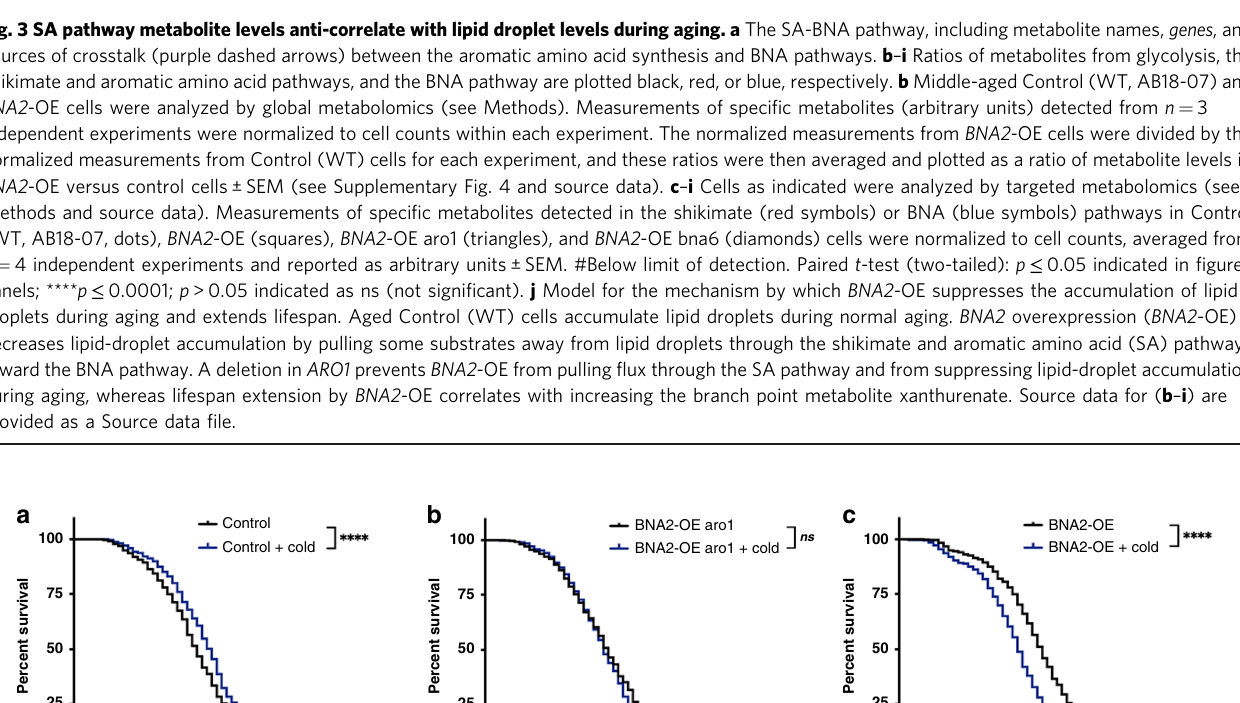
Fig. 4 Increased survival to cold exposure correlates with LD accumulation during aging. a – c Cells as indicated were aged in 30 °C media until median age 16 (middle-age), and then exposed to 4 °C (blue lines) or 30 °C (black lines) media at regular intervals until death (see Methods), and lifespan was analyzed as in Fig. 1f (see Methods). Log-rank test: p > 0.05, not signi fi cant; **** p ≤ 0.0001. a Control (WT, AB18-07, 550 cells at 30 °C, and 525 cells at 4 °C), b BNA2 -OE aro1 Δ (525 cells at 30 and 4 o C), and c BNA2 -OE (550 cells at 30 and 4 °C) were analyzed over n = 4 independent experiments. Average median and maximal lifespans at 30 °C (±SEM): Control 25.8 ± 1.3, 41 ± 1.9; BNA2 -OE aro1 Δ 25.1 ± 2.2, 44.3 ± 4.2; BNA2 -OE 29.5 ± 1.7, 48.8 ± 2.5. Average median and maximal lifespans at 4 °C ( + SEM): Control 27.5 ± 1.3, 43.3 ± 2.5; BNA2 -OE aro1 Δ 25 ± 1.8, 45 ± 4.6; and BNA2 -OE 24.8 ± 1.3, 40 ± 3.7. Source data for ( a – c ) are provided as a Source data fi metabolomics data RAW fi les were converted to mzXML fi les using msconvert resuspended in water for analysis on a C18 column in negative ion mode, and from the open source software package ProteoWizard, version 3.0.8789 (http:// diluted 1:4 into acetonitrile for analysis on a HILIC column in positive ion mode. proteowizard.sourceforge.net/); identity and peak integration were manually All samples were analyzed using two separate LC-MS methods on Vanquish veri fi ed and quanti fi ed using the open source software program Maven, version UPLCs coupled to a Q-Exactive Plus mass spectrometers running Thermo Xcalibur 4.0 (version 4.0.27.10) with Thermo Foundation 3.1 SP1 (version 3.1.83.0) (ThermoFisher Scienti fi c, Waltham, MA). Metabolites analyzed in positive ionization mode were separated using a SeQuant ® ZIC ® -pHILIC column, 5 μ m particle size, 200Å, 150 ×2.1 mm. Mobile phase A was 20mM ammonium carbonate in water (pH 9.2); mobile phase B was (Fig. 3c – i, Source data fi le). Samples were reconstituted in 50:50 (v/v) mixture of acetonitrile. The fl ow rate was 150 μ L/min and the gradient was t = − 6, 80% B; t = 100% methanol and 0.4% (v/v) acetic acid in water, and injected into a 1290 0, 80% B; t = 2.5, 73% B; t = 5, 65% B, t = 7.5, 57% B; t = 10, 50% B; t = 15, 35% B; Agilent UPLC system coupled to an Agilent 6520 Quadrupole Time of Flight (Q- t = 20; 20% B; t = 22, 15% B; t = 22.5, 80% B; t = 24; 80% B. The mass TOF). Features were extracted and analyzed using Agilent MassHunter Data spectrometer was operated in positive ion mode using data-dependent acquisition Acquisition and Processing software, and the measurements above the limit of (DDA) mode with the following parameters: resolution = 70,000, AGC target = detection are reported as averages ± SEM from four independent experiments in 3.00E + 06, maximum IT (ms) = 100, scan range = 70 – 1050. The MS 2 parameters each fi gure panel. The measurements (volume in arbitrary units) of each feature were normalized based on the number of cells per sample compared with the were as follows: resolution = 17,500, AGC target = 1.00E + 05, maximum IT number of cells in control (WT) strain, and then analyzed and plotted using (ms) = 50, loop count = 6, isolation window ( m / z ) = 1, (N)CE = 20, 40, 80; Microsoft Excel v16.34 and Graphpad Prism v8.3.1. Standards of each reported under fi ll ratio = 1.00%, Apex trigger(s) = 3 – 10, dynamic exclusion(s) = 25. metabolite were run as a comparison to detect features in experimental samples. Metabolites analyzed in negative ionization mode were separated using a reverse phase ion-pairing chromatographic method with an Agilent Extend C18 RRHD column, 1.8 μ m particle size, 80 Å, 2.1 ×150 mm. Mobile phase A was 10 mM tributylamine, 15mM acetic acid in 97:3 water:methanol pH 4.95; mobile phase B was methanol. The fl ow rate was 200 μ L/min and the gradient was t = − 4, 0% B; t = 0, 0% B; t = 5; 20% B; t = 7.5, 20% B; t = 13, 55% B; t = 15, 95% B; t = 18.5, 95% B; t = 19, 0% B; t = 22, 0% B. The mass spectrometer was operated in negative ion mode using data-dependent acquisition (DDA) mode with the following parameters: resolution = 70,000, AGC target = 1.00E + 06, maximum IT (ms) = 100, scan range = 70 – 1050. The MS 2 parameters were as follows: resolution = 17,500, AGC target = 1.00E + 05, maximum IT (ms) = 50, loop count = 6, isolation window ( m / z ) = 1, (N)CE = 20, 50, 100; under fi ll ratio = 1.00%, Apex trigger(s) = 3 – 12, dynamic exclusion(s) = 20. Metabolites were identi fi ed by matching fragmentation spectra and retention times from chemical above. 20 ×10 6 cells were washed twice in PBS, and then incubated in 3mg/mL standards that were previously analyzed on the same instrumentation. Global (w/v) EZ-Link Sulfo-NHS-LC-Biotin (Thermo Scienti fi c, 21335) in PBS (30 min,